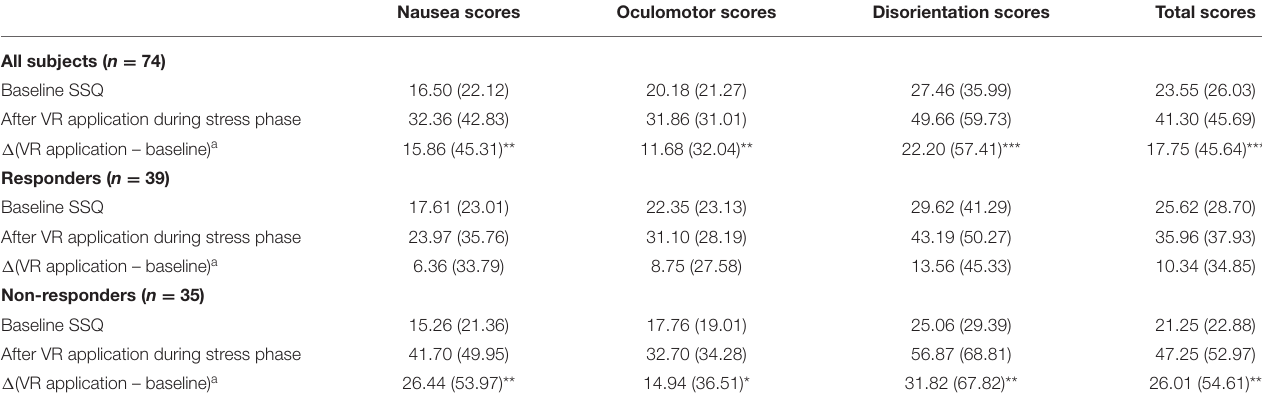
TABLE 5 | Changes of SSQ before and after stress exposure using intentionally generated shaking